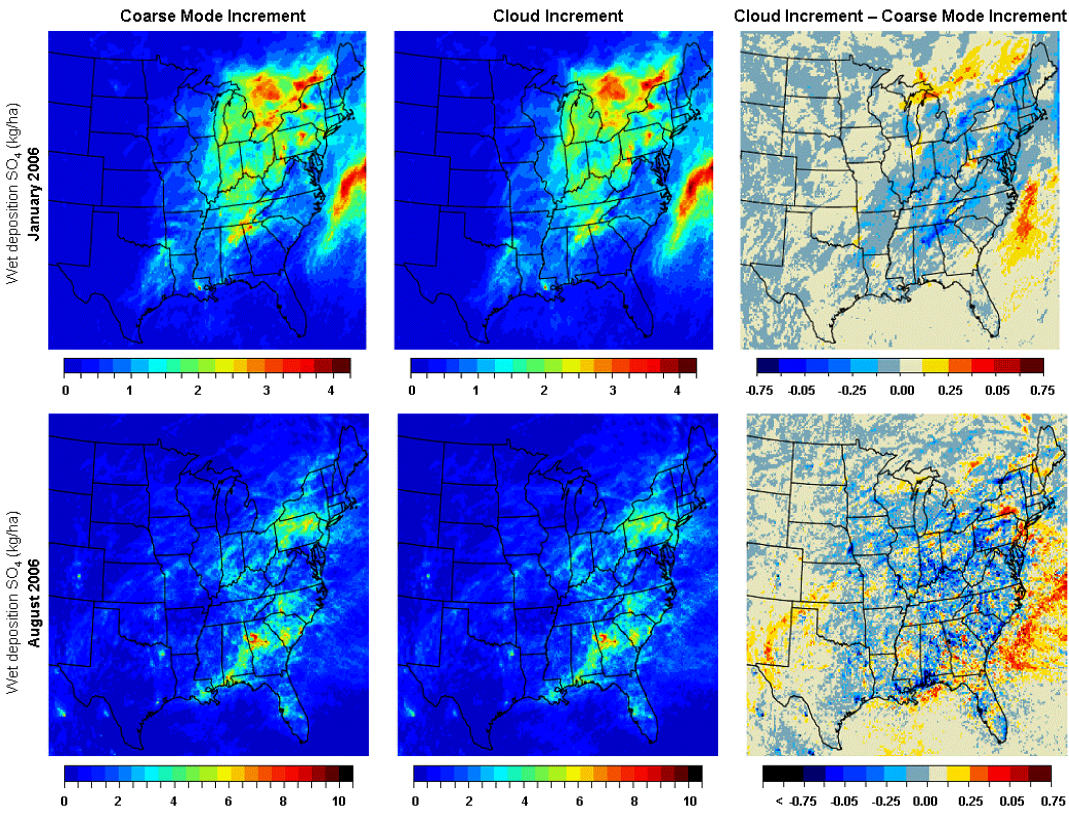
Fig. 8. Monthly total SO 2 − wet deposition (kg/ha) for January (top row) and August (bottom row) 2006 for the previous model (left column), 4 revised model (middle column) and their difference (right column).